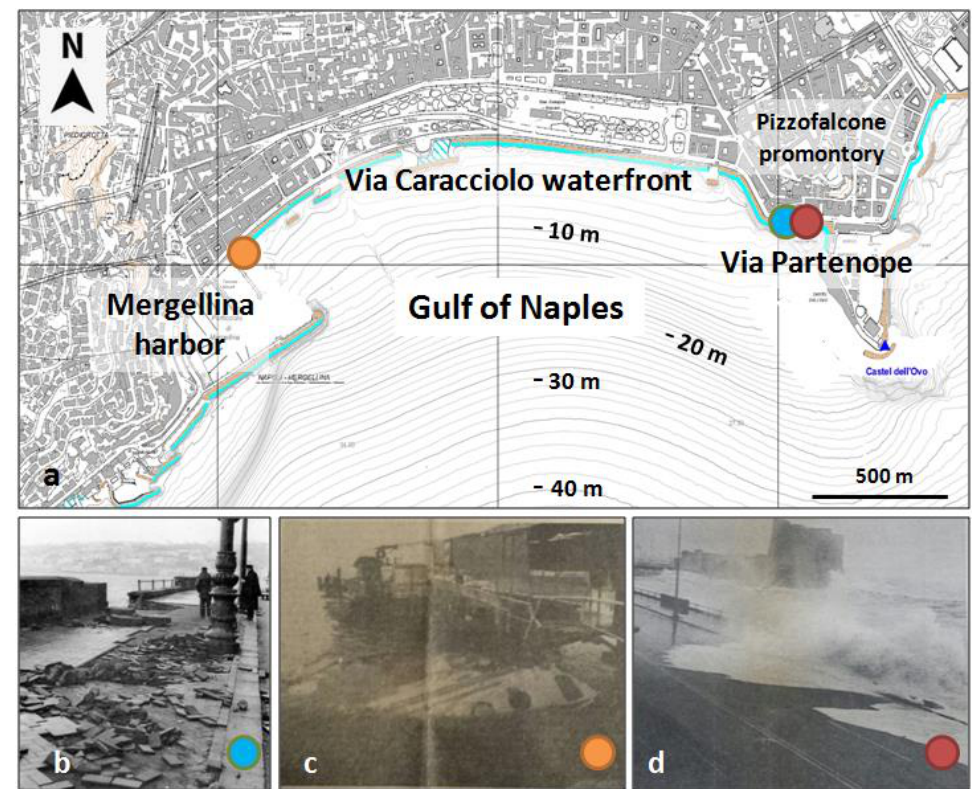
Figure 3. Via Caracciolo-Via Partenope waterfront ( a ) between Mergellina (West) and Castel dell’Ovo (East) (map modified by Reference [41], with images of the effects of historical sea storms); ( b ) destruction of road pavement in Via Partenope on 4 November 1966; ( c ) hydrofoil sunk at Mergellina maritime station on 23 December 1979; ( d ) large waves invade the roadway of Via Partenope on 11 January 1987, when a “tide up” phenomenon occurred along the coast, due to the occurrence of extremely low-pressure values (lower than 990 hPa) and strong breaking waves process in the previous hours. Photos are courtesy of “Il Mattino” newspaper, Naples.